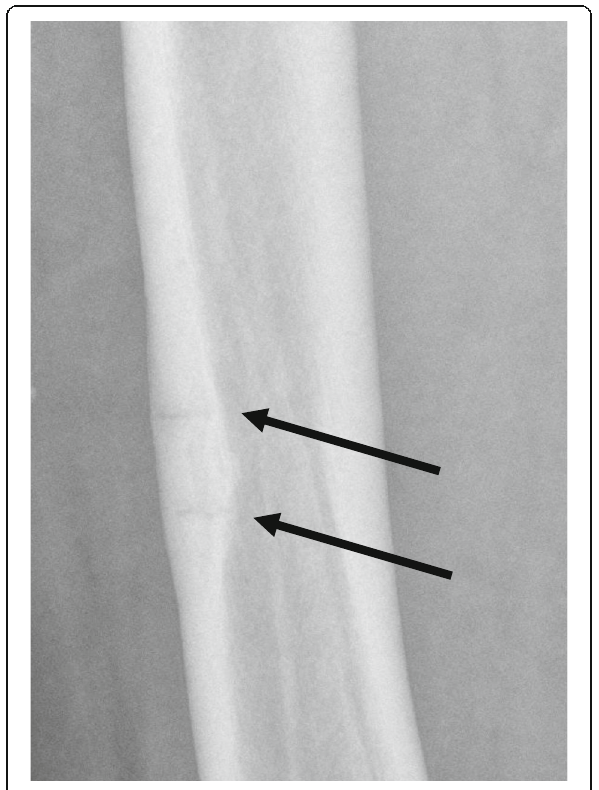
Fig. 5 Bisphosphonate insufficiency fractures seen on a plain film of the